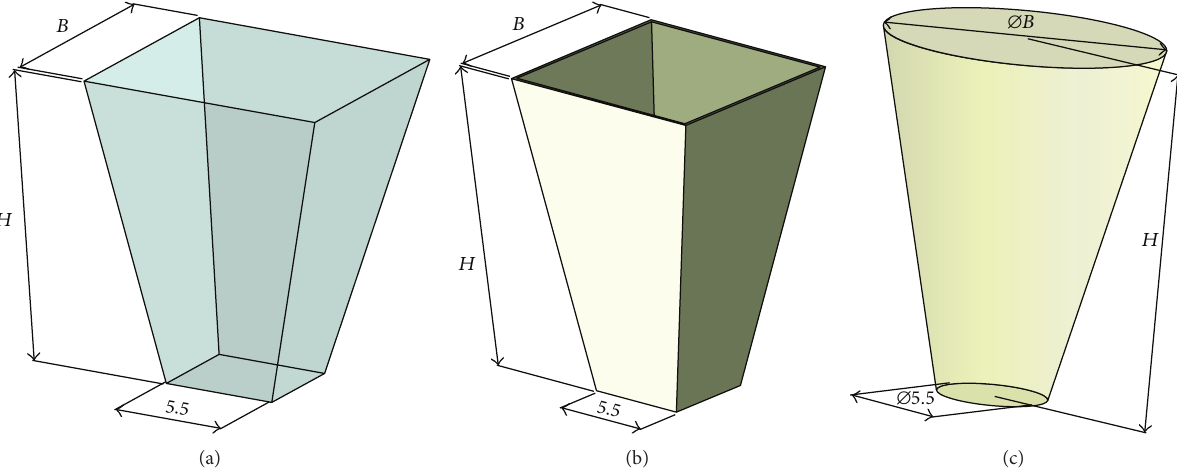
Figure 2: Three types of SOEs: (a) refractive pyramid, (b) reflective pyramid, and (c) refractive cone.